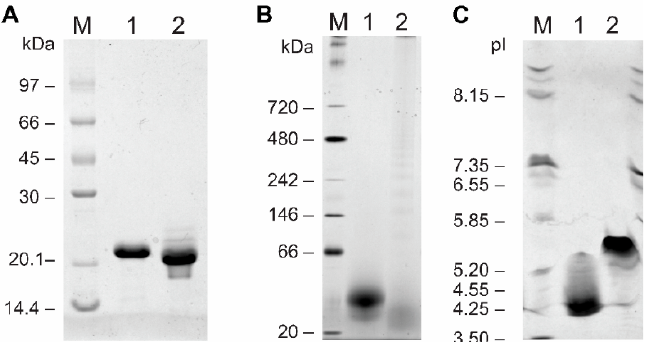
Figure 2. Polyacrylamide electrophoretic analyses of CCP1 and CCP2. ( A ) SDS-PAGE analysis in a 15% polyacrylamide gel under denaturing conditions showing Coomassie blue staining; ( B ) blue native PAGE analysis; ( C ) isoelectric focusing analysis. Lane M: appropriate standard protein mix; lane 1: CCP1; lane 2: CCP2.